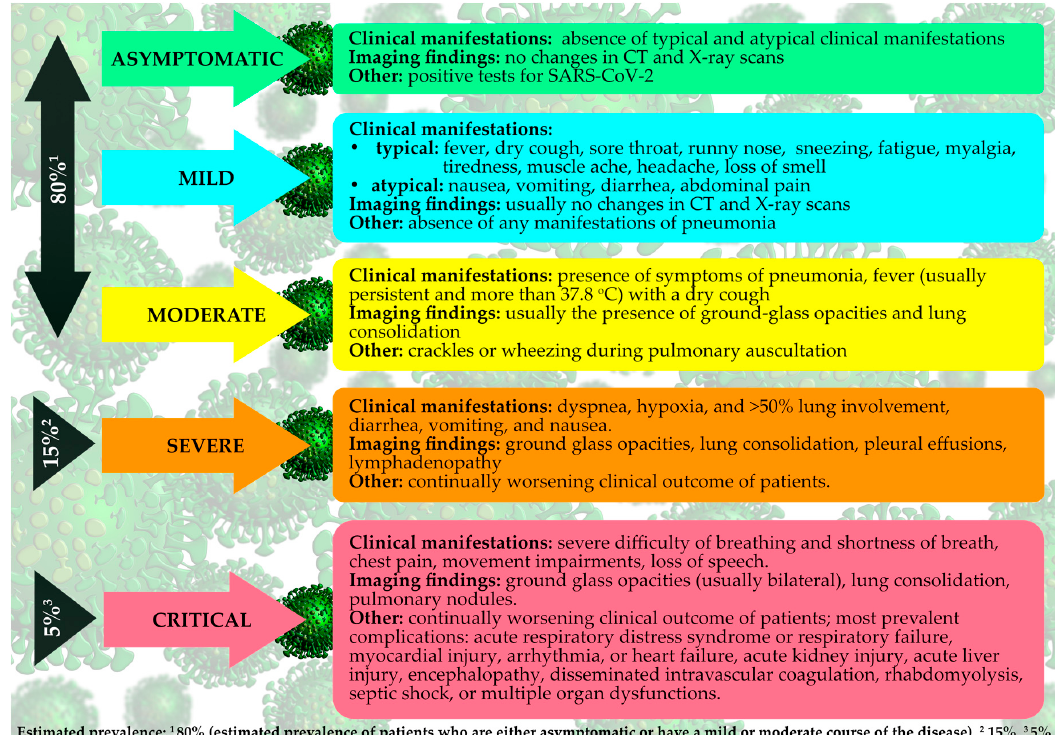
Figure 1. The severity of SARS-CoV-2 infection with typical characteristics.